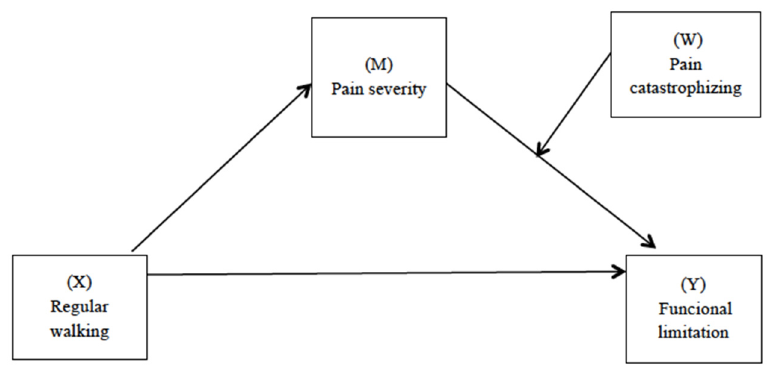
Figure 1. Path diagram illustrating the moderate mediation model.